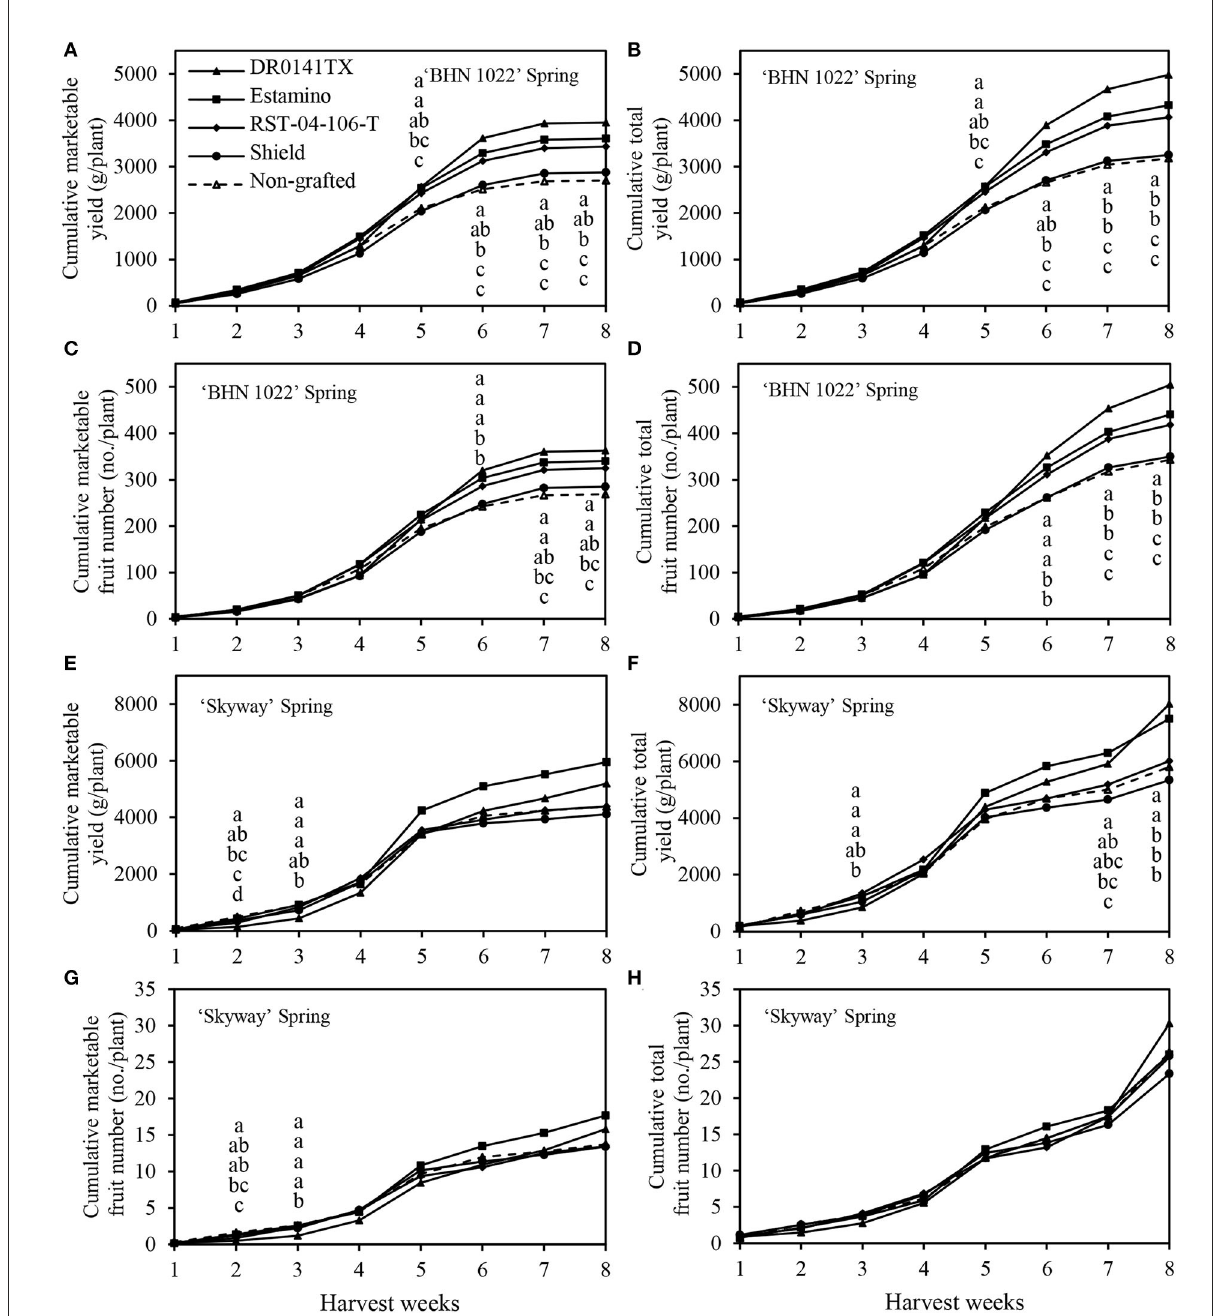
FIGURE3 Cumulative marketable and total fruit yields and numbers per plant of the grafted ‘BHN 1022’ grape tomato and ‘Skyway’ beefsteak tomato scions during the spring growing season (14 February to 18 June 2020). Green fruits at final harvest were excluded. (A) Cumulative marketable yield of ‘BHN 1022’. (B) Cumulative total yield of ‘BHN 1022’. (C) Cumulative marketable fruit number of ‘BHN 1022’. (D) Cumulative total fruit number of ‘BHN 1022’. (E) Cumulative marketable yield of ‘Skyway’. (F) Cumulative total yield of ‘Skyway’. (G) Cumulative marketable fruit number of ‘Skyway’. (H) Cumulative total fruit number of ‘Skyway’. For the same harvest week, data with the same letter are not significantly different at P ≤ 0.05 according to Fisher’s LSD